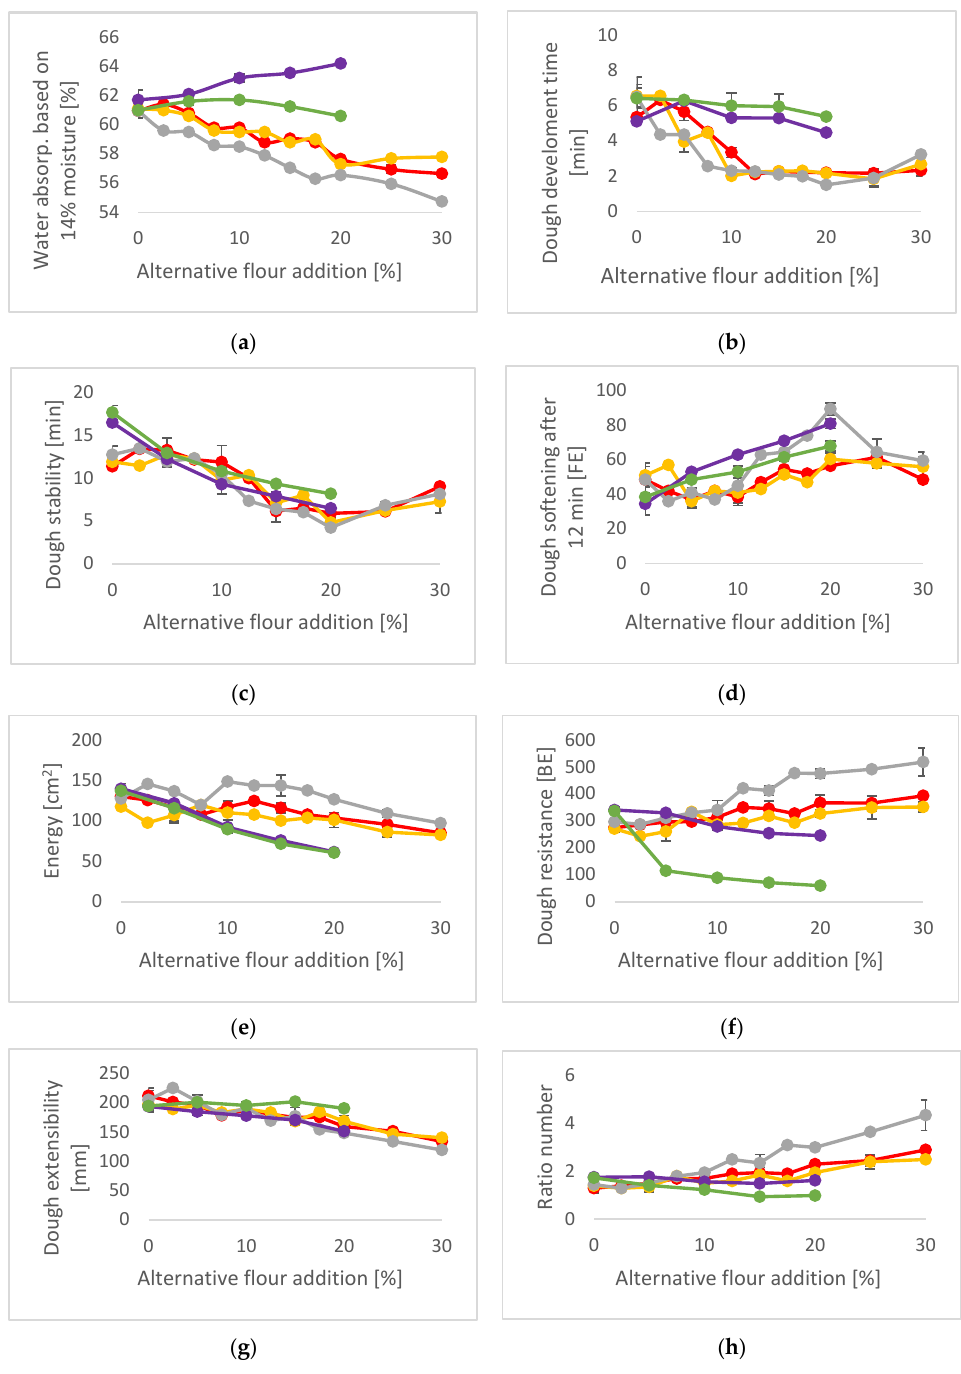
Figure 2. Farinograph ® and Brabender Extensograph ® data; Red: Red sorghum, Yellow: White sorghum, Grey: Millet, Purple: Amaranth, Green: Buckwheat; ( a ) Farinograph: Water absorption based on 14% moisture [%]; ( b ) Farinograph: Dough development time [min]; ( c ) Farinograph: Dough stability [min]; ( d ) Farinograph: Dough softening after 12 min [FE]; ( e ) Extensograph: Energy [cm 2 ]; ( f ) Extensograph: Dough resistance [BE]; ( g ) Extensograph: Dough extensibility; ( h ) Extensograph: Ratio